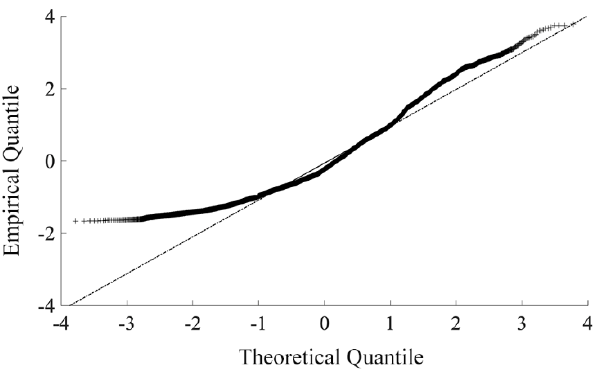
Figure 2. The scatter plot of empirical quantile and theoretical quantile of the daily terrestrial water storage.